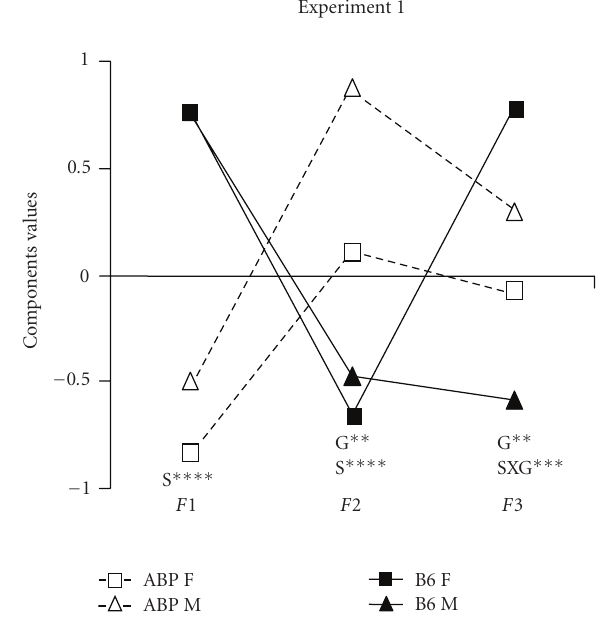
Figure 1: Mean scores by strain and gender of component values, S = strain e ff ect; G = gender e ff ect; SXG = strain-gender interaction, ∗∗ = P < . 01; ∗∗∗∗ = P < .